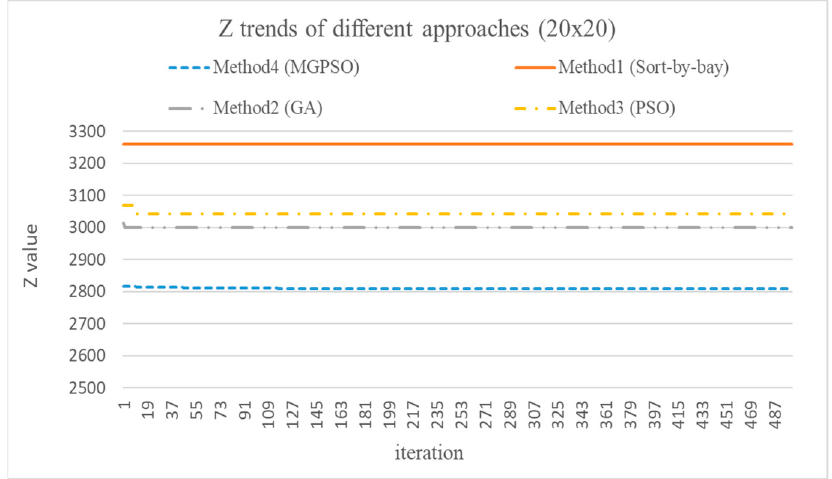
Figure 11. Z trends of different approaches (the problem size 20 × 20).